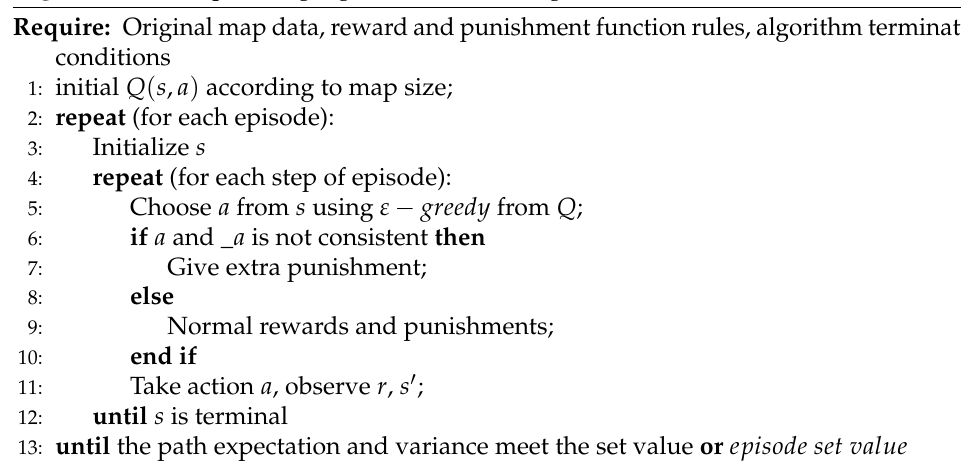
Algorithm 1 Path planning algorithm considering cumulative error